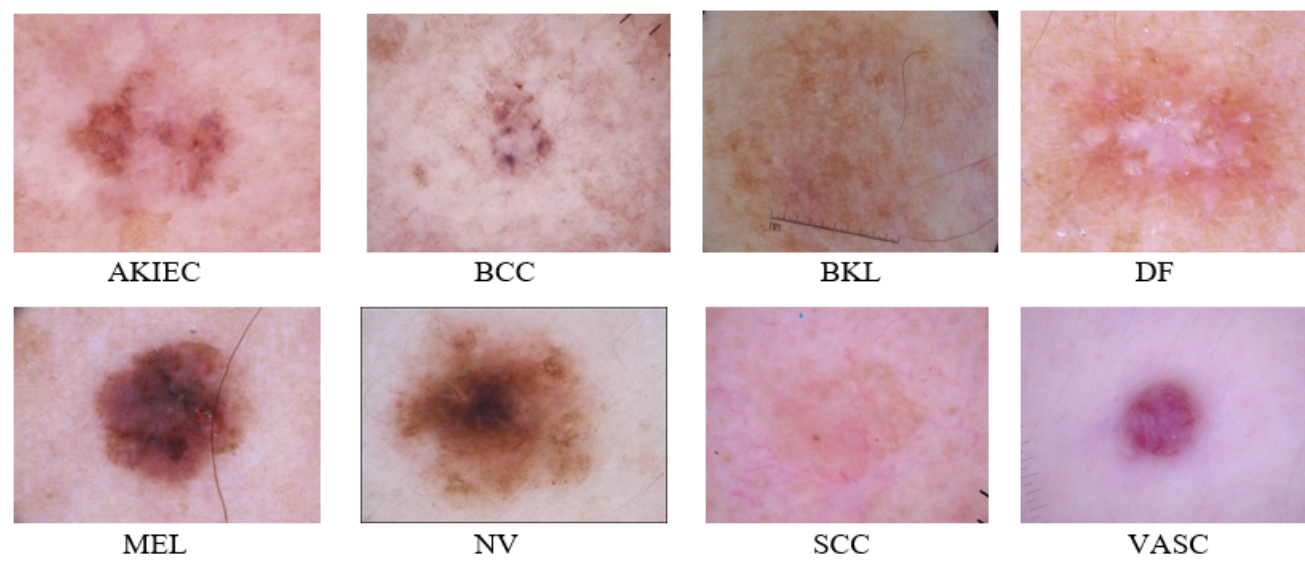
Figure 5. ISIC 2019 different skin lesions